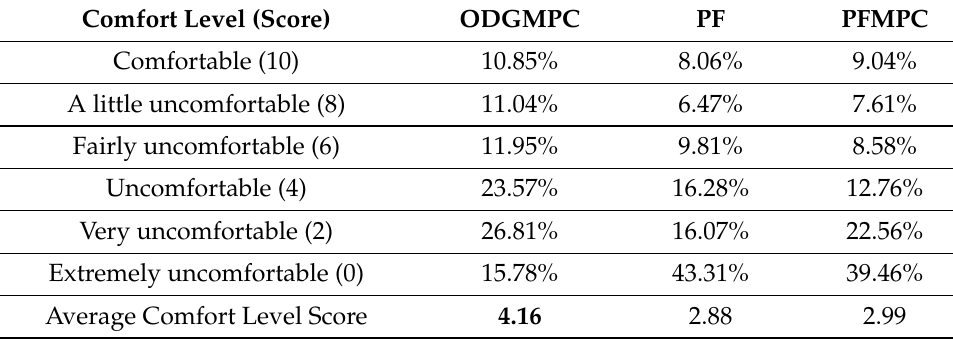
Figure 26. Results of the acceleration from Scenario 3 for two static obstacles. Table 10. Average result scores for 10 experiments with two static